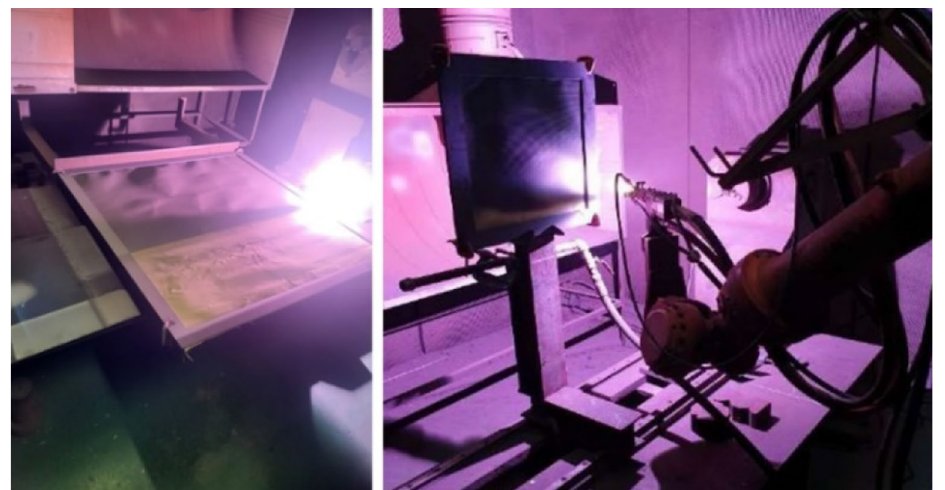
Figure 9. Plasma thermal coating–based tungsten spraying